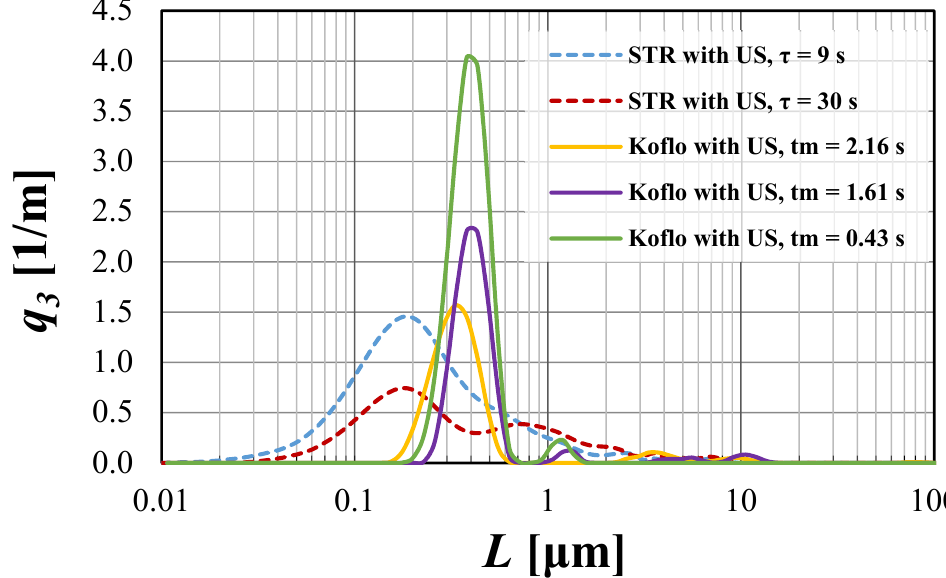
Figure 7. The influence of residence time on particle density distribution q 3 for both examined reactor types.